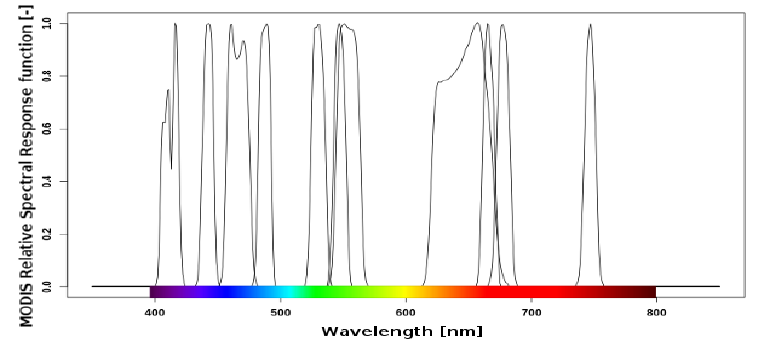
Figure 2. The Relative Spectral Response of the OLCI